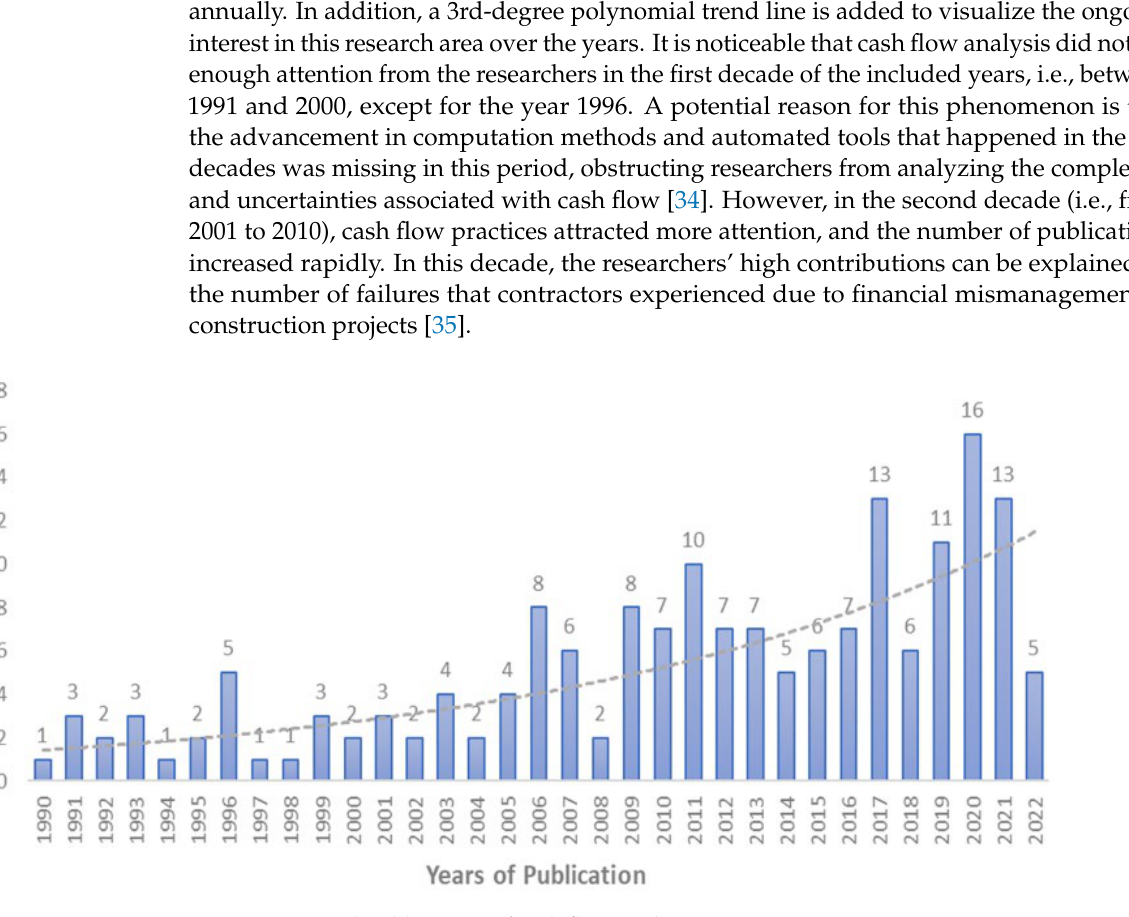
Figure 3. Annual publications of cash flow analysis .